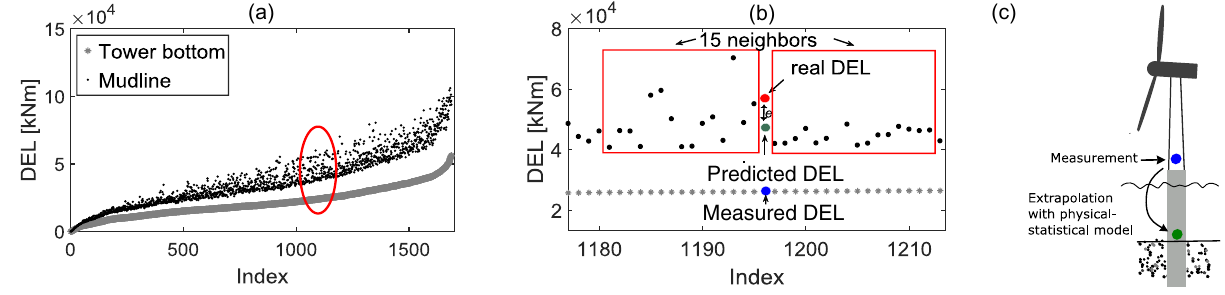
Figure 1. (a) DELs at tower bottom (T-DELs) sorted ascending for 1700 load cases. Corresponding DELs at mudline (M-DELs) are plotted as function of T-DELs. (b) Zoom into picture above. The M-DEL (green dot) corresponding to a measured T-DEL (blue dot) is estimated as mean value of 15 nearest neighbor values (from simulations) on each side. It deviates from the real M-DEL with an estimation error e . (c) Schematic setup of load monitoring concept. Measured T-DELs are extrapolated to other